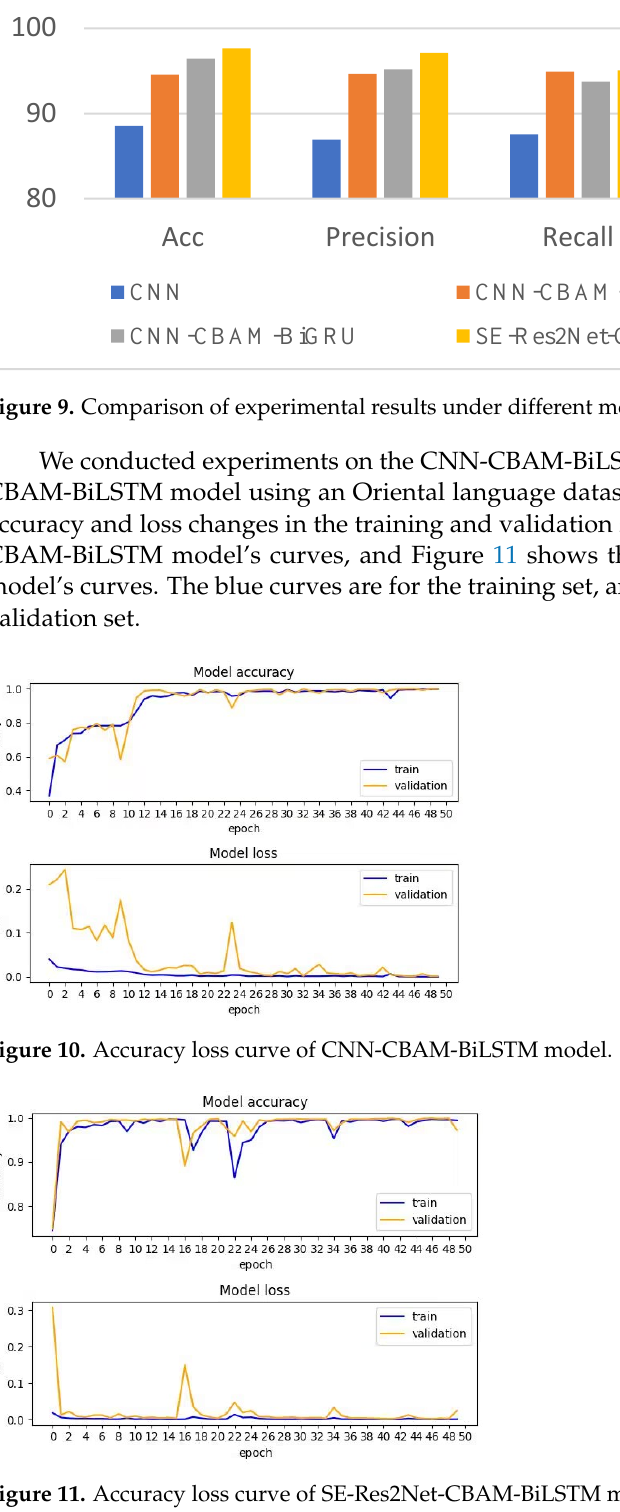
Figure 9. Comparison of experimental results under different models.